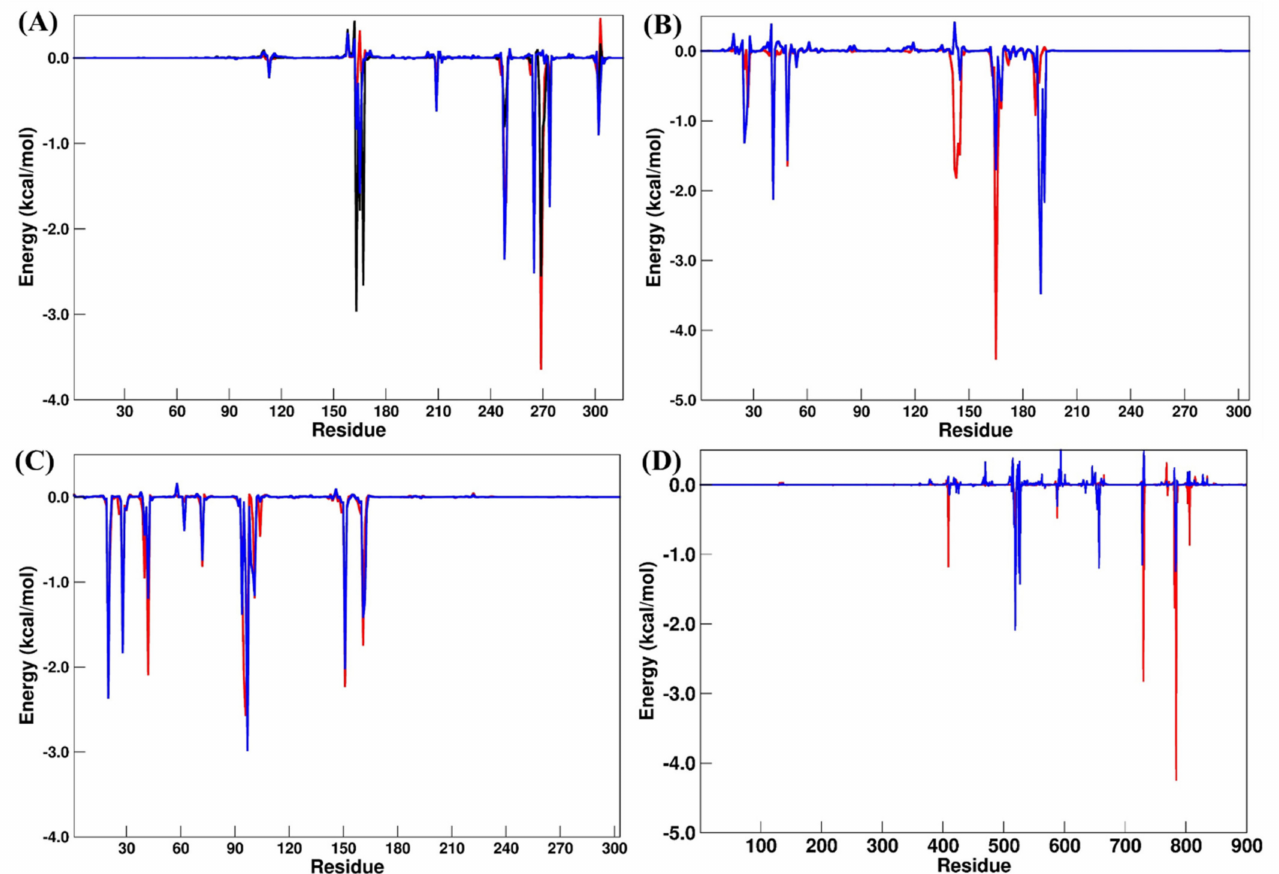
Figure 9. Residual decomposition plot for ( A ) PLpro (GRM, red; OUB, blue; SLM, black), ( B ) Mpro (X77, red; OUB, blue), ( C ) AAK1 (LKB, red; NIS, blue) and ( D ) RdRp (RDV, red; DIG, blue) systems. All values are reported in